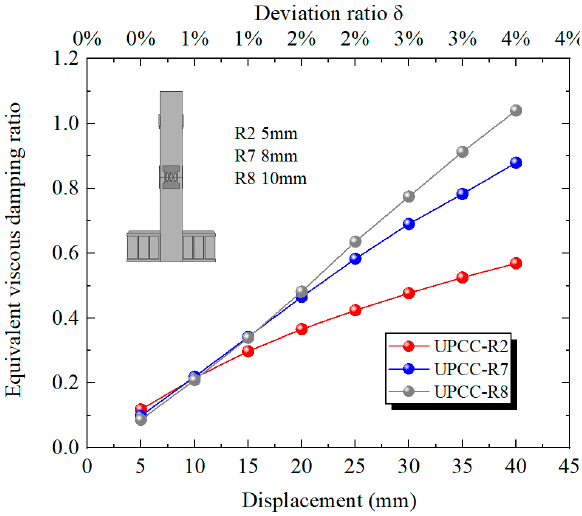
Figure 32. Equivalent viscous damping ratio under different thicknesses of EREDL.